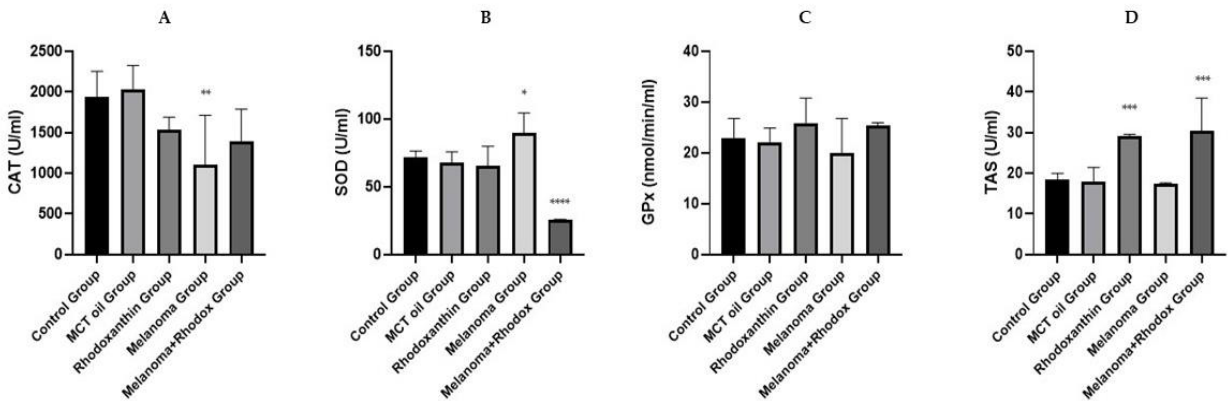
Figure 5. Enzymatic antioxidant activity and total antioxidant status in plasma. ( A ) Catalase activity. ( B ) Superoxide-dismutase activity. ( C ) Glutathione-peroxidase activity. ( D ) Total antioxidant status. Values are expressed as mean ± standard deviation SD from three independent experiments. Statis- tical significance level * p < 0.05, ** p < 0.01, *** p < 0.01 and **** p < 0.0001.